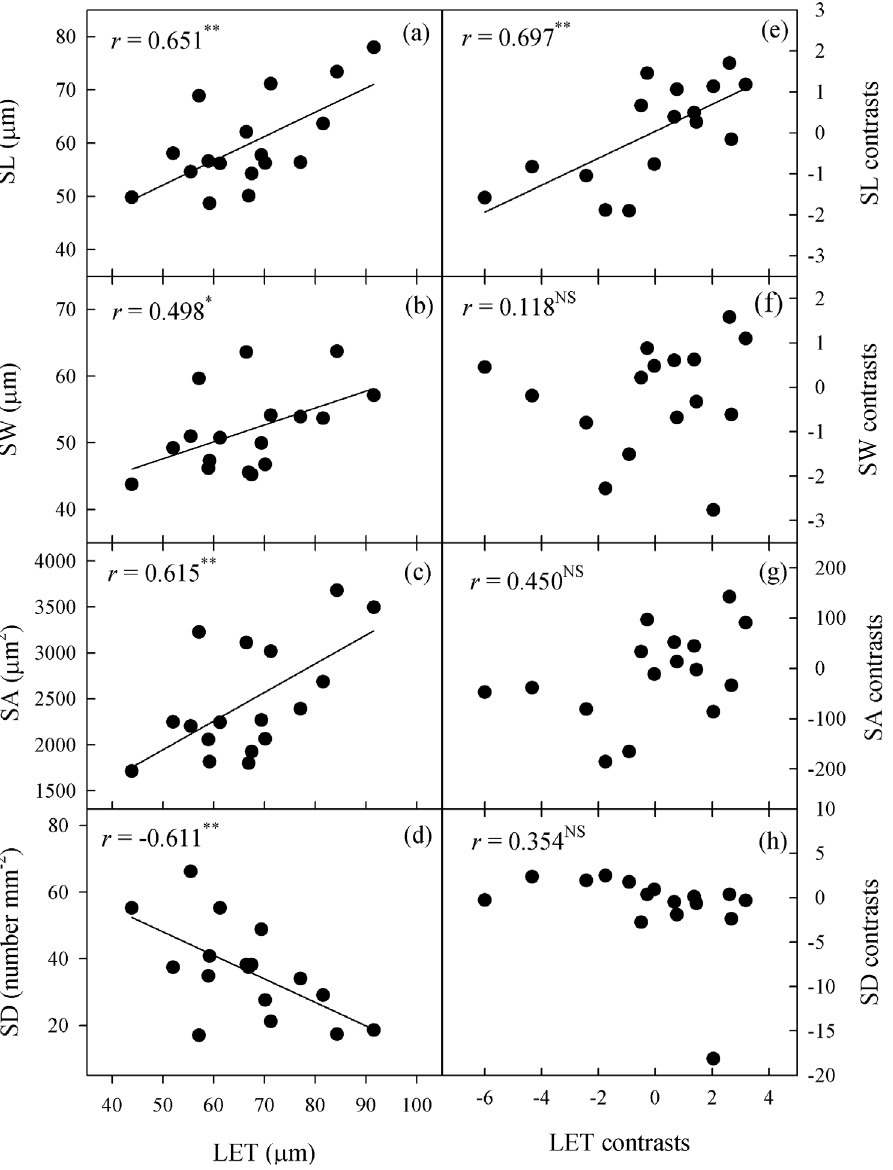
Figure 5. Correlations of lower epidermal thickness (LET) with stomatal traits. Plate (a) to (d), Pearson’s regressions; and plate (e) to (h), phylogenetically independent contrast correlations. SL, stomatal length; SW, stomatal width; SA, stomatal area; and SD, stomatal density.